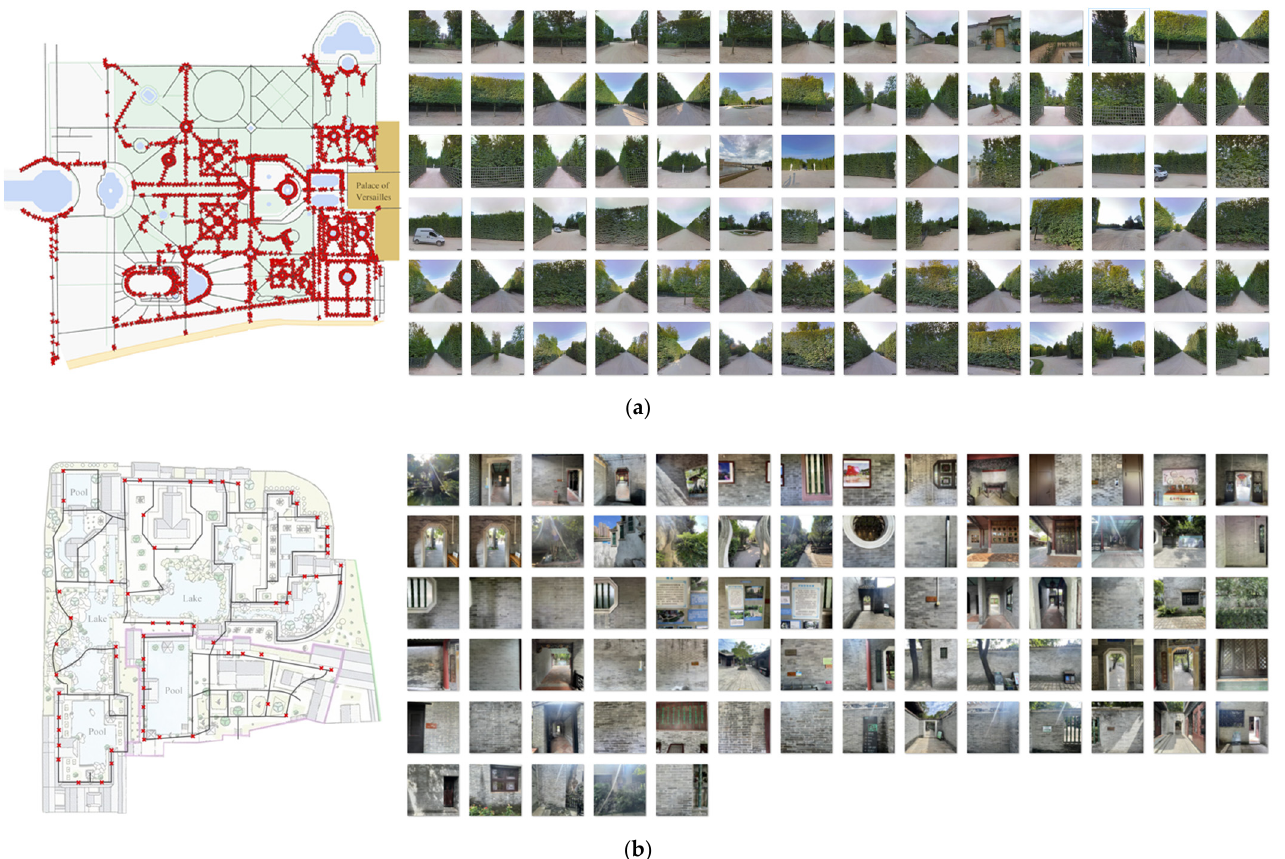
Figure 6. The distribution of ‘Textured but Simple’ scenario and its sample images in Gardens of Versailles ( a ) and the Qinghui Garden ( b ).